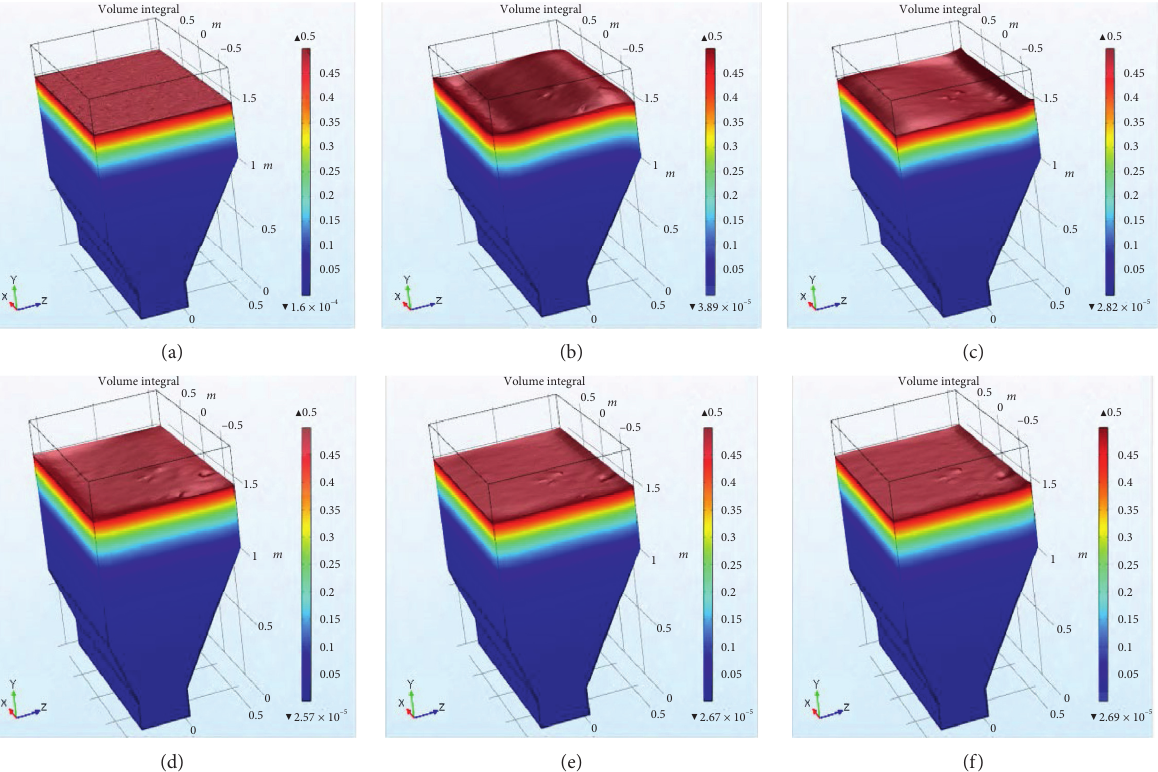
Figure 7: Simulated changes in fluid motion. (a) t � 0s. (b) t � 0.5s. (c) t � 1.5 s. (d) t � 2.5 s. (e) t � 3.5 s. (f) t � 4 s. m